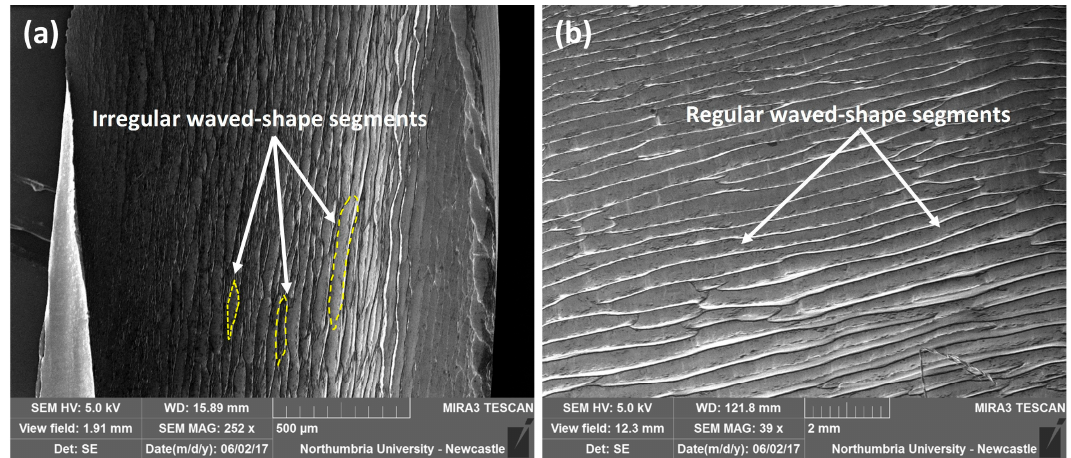
Figure 13. Effect of cutting speed on chip morphology of the free surfaces for Cut-list at: ( a ) 95 m/min; and ( b ) 200 m/min.